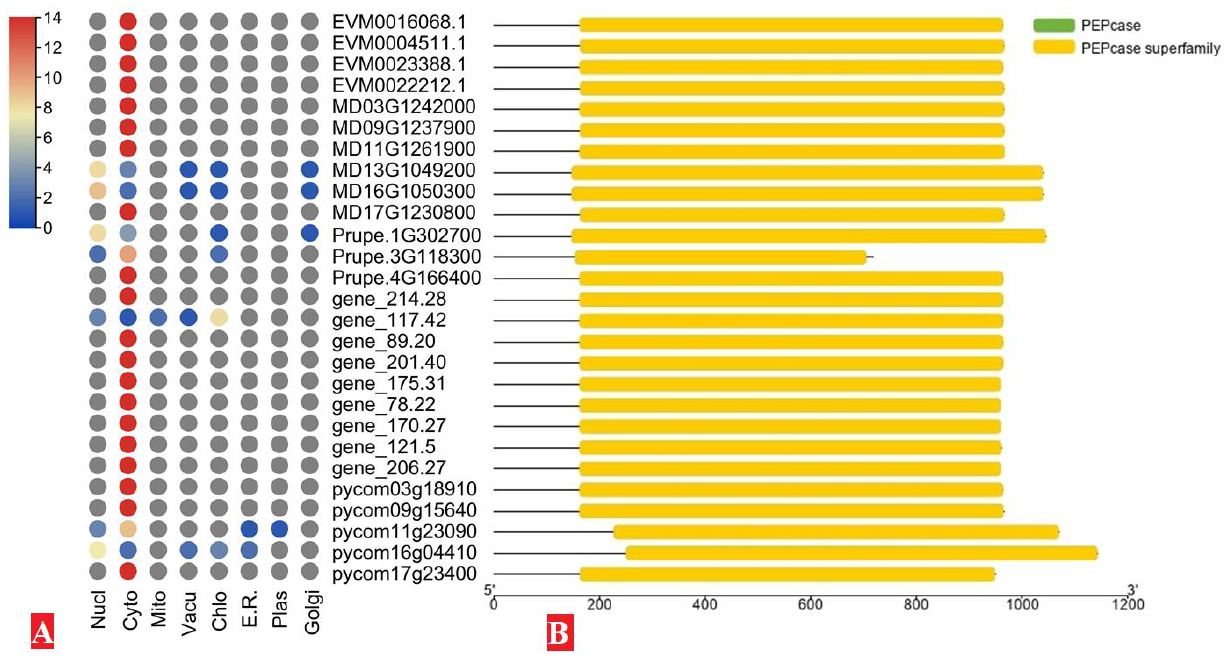
Figure 1. ( A ) Prediction of subcellular localization of PEPC proteins of five Rosaceae species. Higher signal levels are shown in red, lower signal levels are denoted in blue, while the white color repre- sents no available data. Abbreviations: Nucl — Nucleus; Cyto — Cytonuclear; Mito — Mitochondria; Vacu — Vacuole; Chlo — Chloroplast; E.R. — Endoplasmic reticulum; Plas — Plasma membrane;